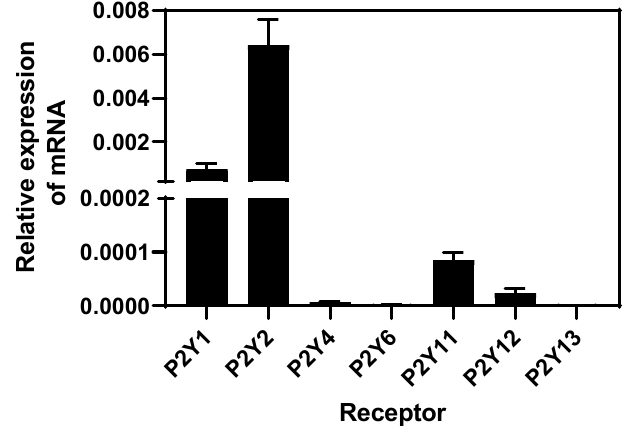
Figure 3. Levels of expression of mRNA P2Y subtype receptors in BEND cells. Total RNA was isolated from BEND cells and RT-qPCR for P2Y subtype receptors was performed. Level of expression of each subtype receptor was determined by the 2 − ∆∆ Ct method. n = 3 independent experiments.